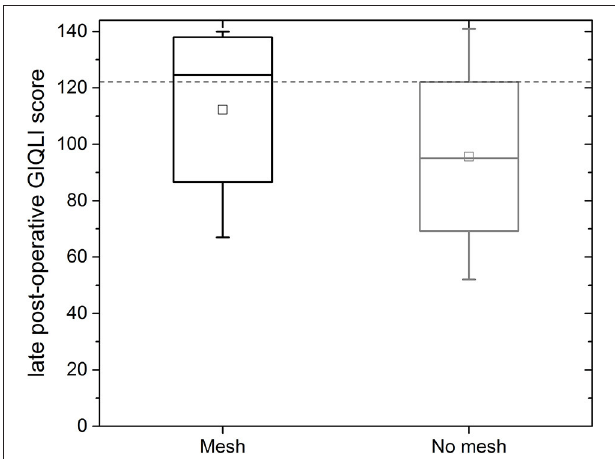
FIGURE 6 | GIQLI score for all follow-up patients with mesh (black box, left) and for patients without mesh (gray, right); the GIQLI is scored by totaling the points from the survey. This figure shows the data for all patients as a median, quartiles and range; the dotted line indicates the average score of a healthy subject